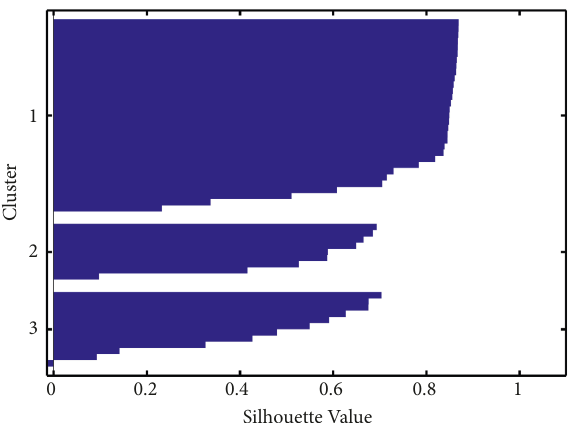
Figure 6: Silhouette value of the scroll wheel damage character- istics divided into three clusters.